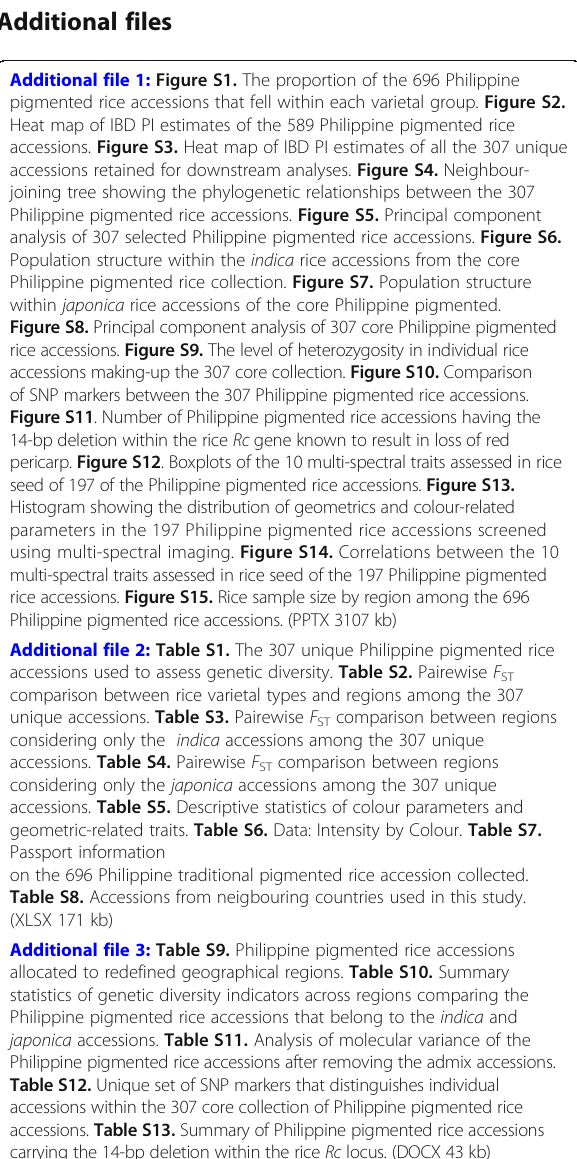
geometric-related traits. Table S6. Data: Intensity by Colour. Table S7. Passport information on the 696 Philippine traditional pigmented rice accession collected. Table S8. Accessions from neigbouring countries used in this study. (XLSX 171 kb) Additional file 3: Table S9. Philippine pigmented rice accessions allocated to redefined geographical regions. Table S10. Summary statistics of genetic diversity indicators across regions comparing the Philippine pigmented rice accessions that belong to the indica and japonica accessions. Table S11. Analysis of molecular variance of the Philippine pigmented rice accessions after removing the admix accessions. Table S12. Unique set of SNP markers that distinguishes individual accessions within the 307 core collection of Philippine pigmented rice accessions. Table S13. Summary of Philippine pigmented rice accessions carrying the 14-bp deletion within the rice Rc locus. (DOCX 43 kb) Abbreviations a*: (green – red redness); AMOVA: Analysis of Molecular Variance; ANOVA: One-way analysis of variance; ARMM: Autonomous Region of Muslim Mindanao; b*: (blue – yellow; yellowness); bHLH: Basic Helix-Loop- Helix, MAF: Minor allele frequency; CAR: Cordillera Administrative